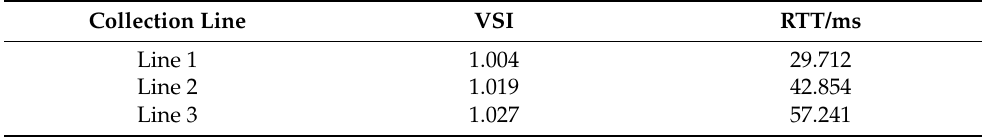
Table 5. HVRT indicators considering the proposed key node as the control